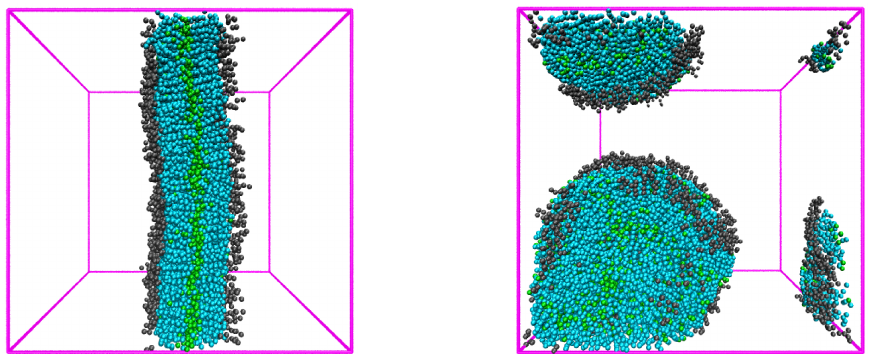
Figure 2. Left : The membrane formed in a 5 10 9 step long simulation run in a box 32 3 using the × interaction a HS = 27. Right : A typical self-assembly formed in a 10 9 step long simulation run in a box 32 3 using the interaction parameter a HS =